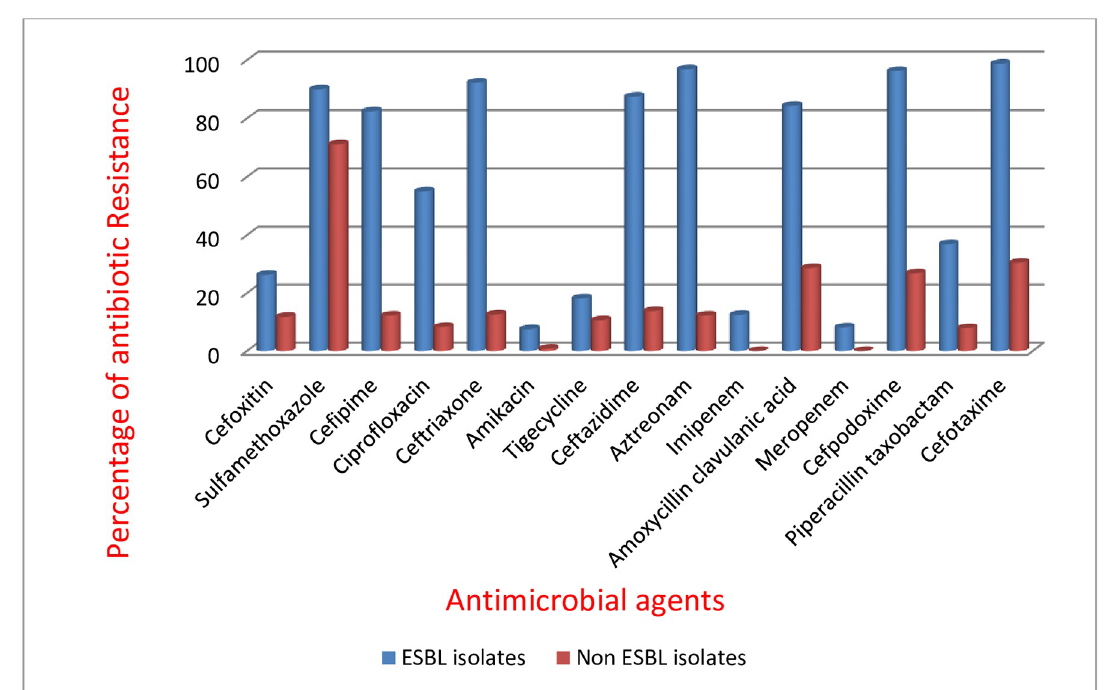
Fig 2. Resistance pattern of ESBL and Non ESBL producing Enterobactericeae